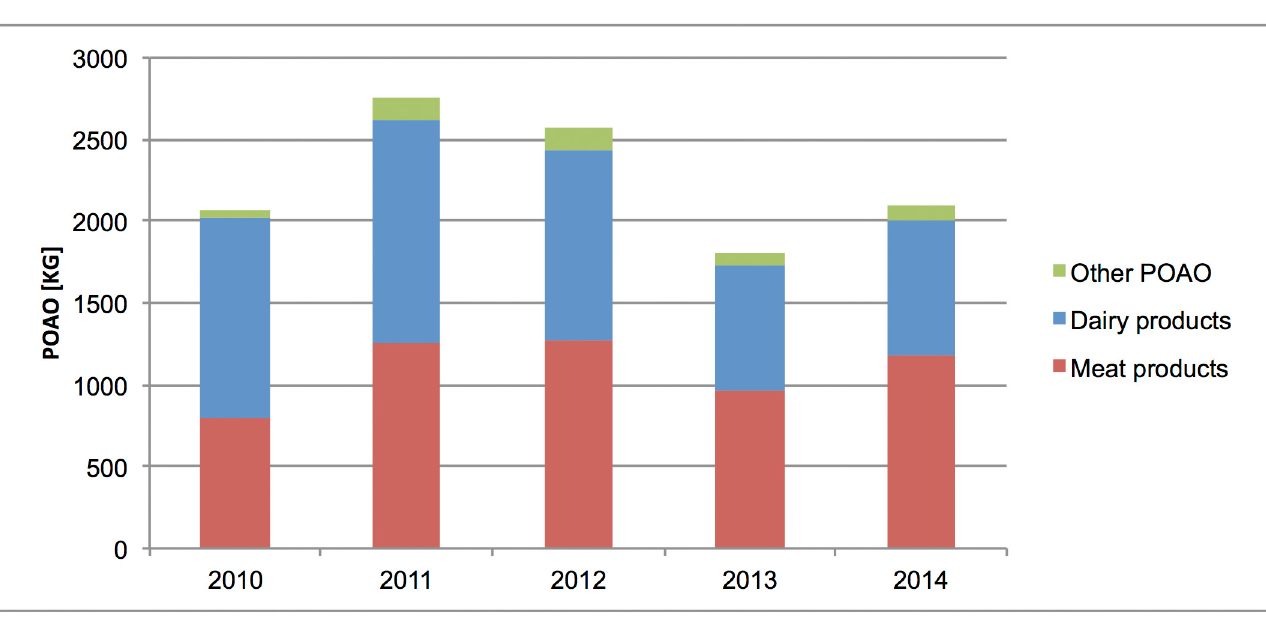
Fig 2. Total amount of seized POAO (in kg) at IA 2, 2010 –